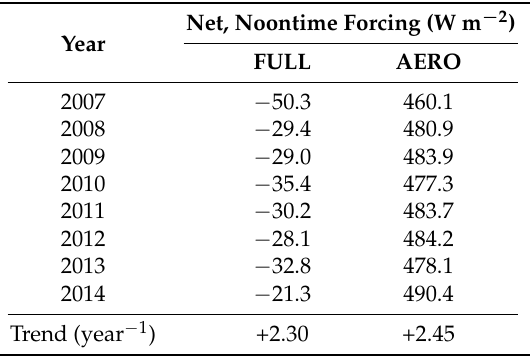
Table 1. Fu-Liou-Gu (FLG) radiative transfer model reported net surface forcing values for each